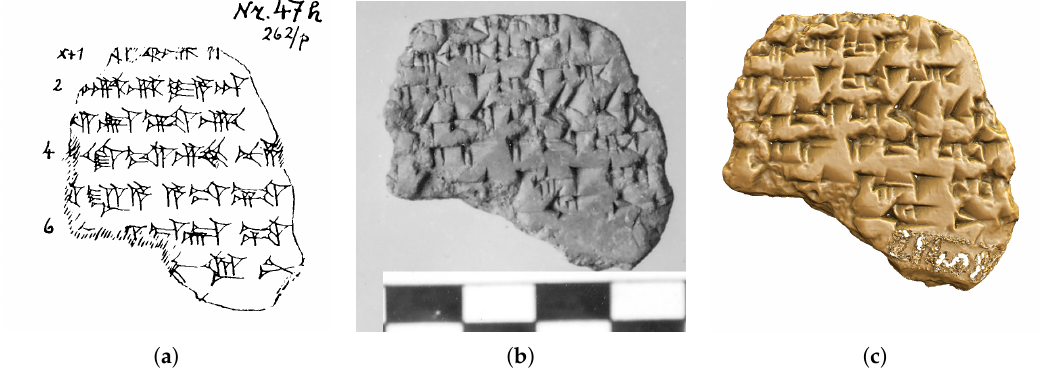
Figure 1. Examples of common cuneiform representations. An autography of cuneiform fragment 262/p is shown in ( a ), with a corresponding photographic documentation in ( b ) and a visualization of a 3D scan in ( c ). Source: